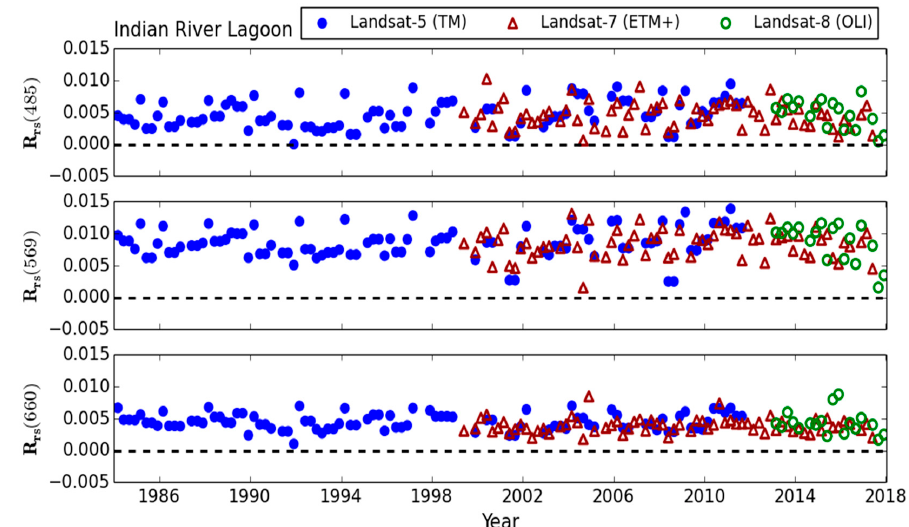
Figure 10. The seasonal composites of R rs products derived from Landsat-5 (solid circles), Landsat-7 (triangle), and Landsat-8 (hollow circles) over the Indian River Lagoon (27.8355N, 80.4515W), Florida. The composites were obtained by taking the median of retrievals in each season. The images were processed via SeaDAS. The methodology for accounting for non-negligible L w (NIR) significantly improved the number of valid (non-negative) retrievals.